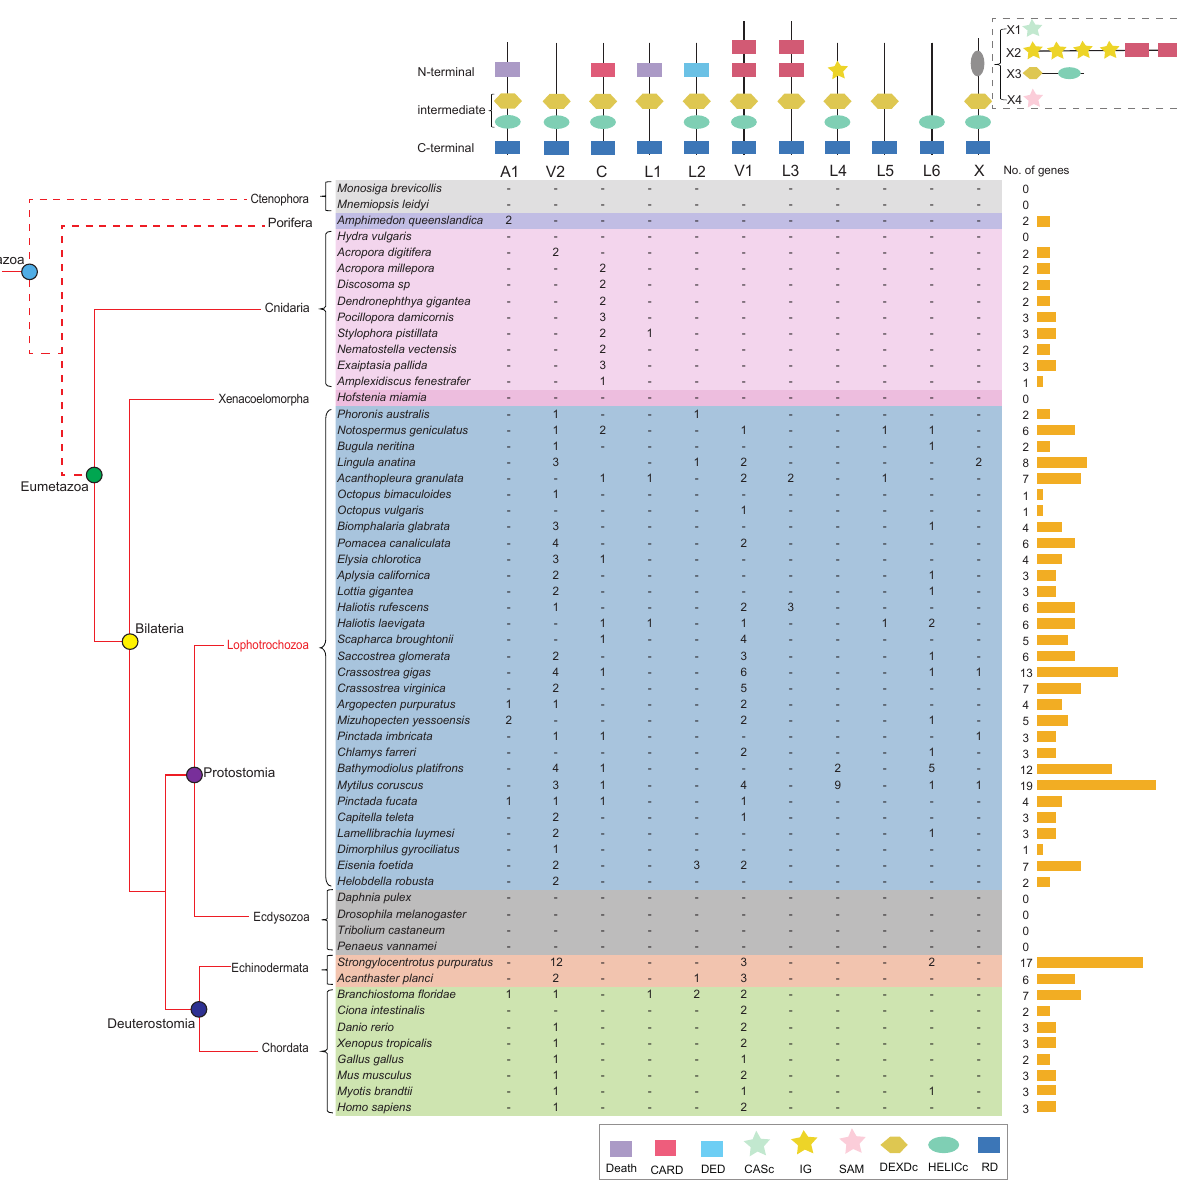
Figure 1. Comparison of gene families encoding RLR immune receptors in representative animals across metazoans. Domain architecture in the lophotrochozoans is more complex than that in other clades. Species colors represent different phyla. Short lines indicate none of the RLRs in the subtype were annotated in this species. Phylogenetic relations among species are indicated by the red cladogram on the left of the table, and dashed lines represent unresolved phylogenetic positions for ctenophores and sponges. The column on the right counts the total number of RLR genes in each species and draws a yellow column chart. RLR diagrams show death family domain in purple, CARD domain in red, DED domain in light blue, CASc domain in light green, IG domain in light yellow, SAM domain in pink, DEXDc domain in yellow, HELICc domain in green, and RD domain in blue. Specifically, the top diagrams show A1, Amphimedon-like type 1; V1, vertebrate-like type 1; V2, vertebrate-like type 2; C, cnidaria-like type; L1, lophotrochozoa-like type 1; L2, lophotrochozoan-like type 2; L3, lophotrochozoan-like type 3; L4, lophotrochozoan-like type 4; L5, lophotrochozoan-like type 5; and L6, lophotrochozoan-like type 6. X implies four specific structural features